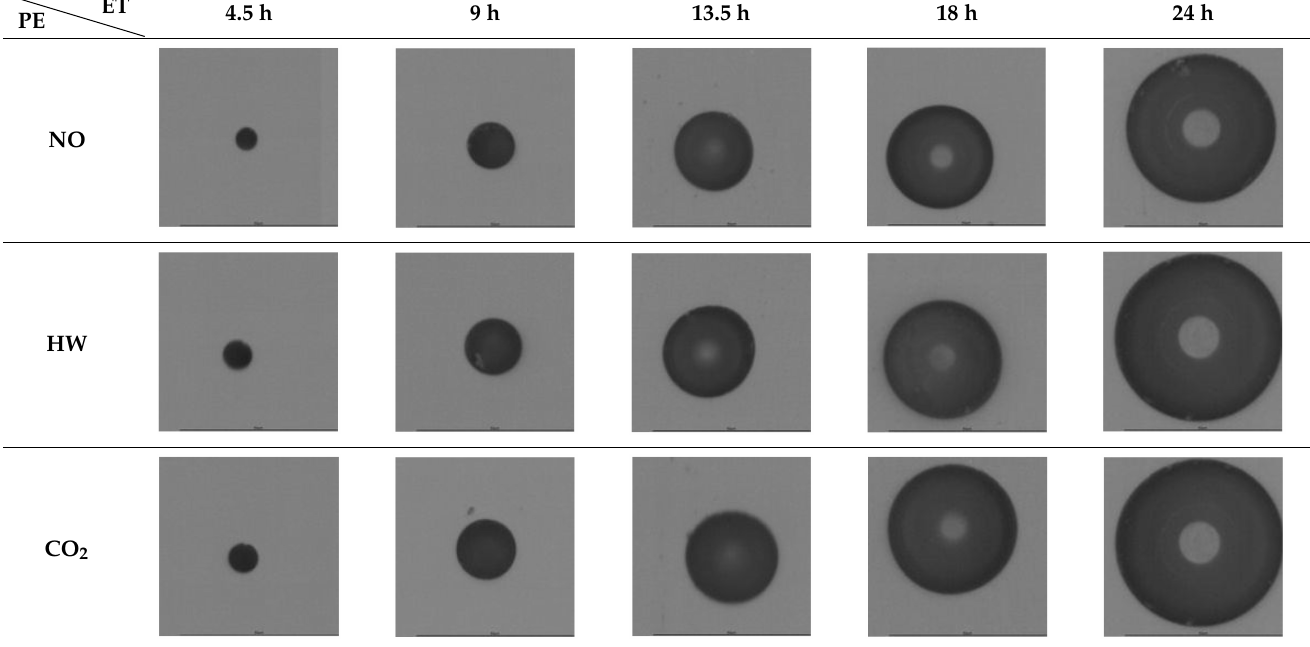
Table 14. Tracks obtained for different etching times and pre-etching treatments for 241 Am